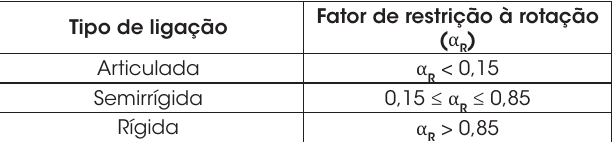
onde (EI) : rigidez secante da viga conforme ABNT NBR 6118 [25] sec L : vão efetivo entre os apoios, ou seja, a distância entre os cen - ef tros de giro nos apoios R : rigidez secante ao momento fletor da ligação viga-pilar. A ri - sec